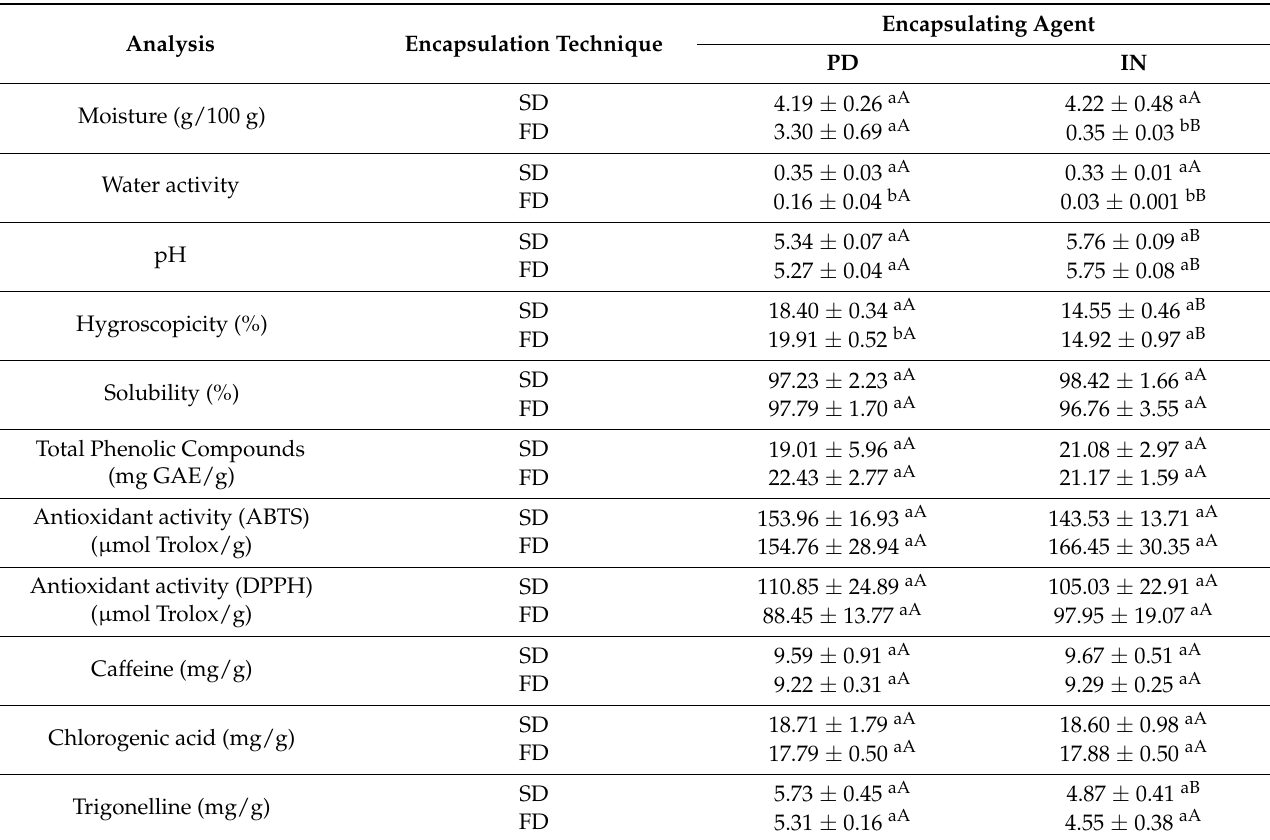
Table 1. Effect of encapsulation techniques and wall materials on the characteristics of the encapsu- lated